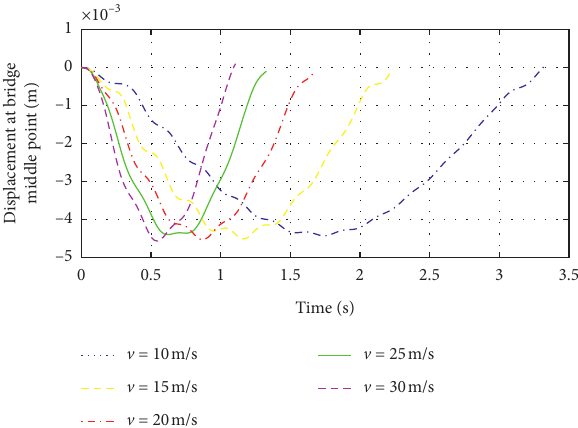
Figure 16: Dynamic response of bridge at the middle